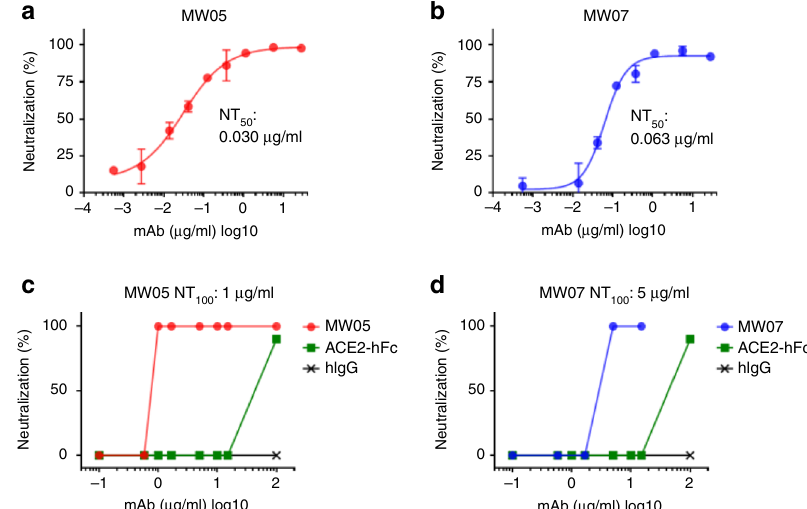
Fig. 2 Neutralizing activities of MW05 and MW07. a , b SARS-CoV-2 pseudovirus neutralizing activities of MW05 and MW07 were evaluated on Huh7 cells. Fifty percent neutralization titer (NT 50 ) was calculated by fi tting the luciferase activities from serially diluted antibodies to a sigmoidal dose – response curve. The average ± SD from two independent experiments with technical duplicates is shown. c , d SARS-CoV-2 authentic virus-neutralizing activities of MW05 and MW07 were evaluated using Vero E6 cells. One hundred percent neutralization titer (NT 100 ) was labeled